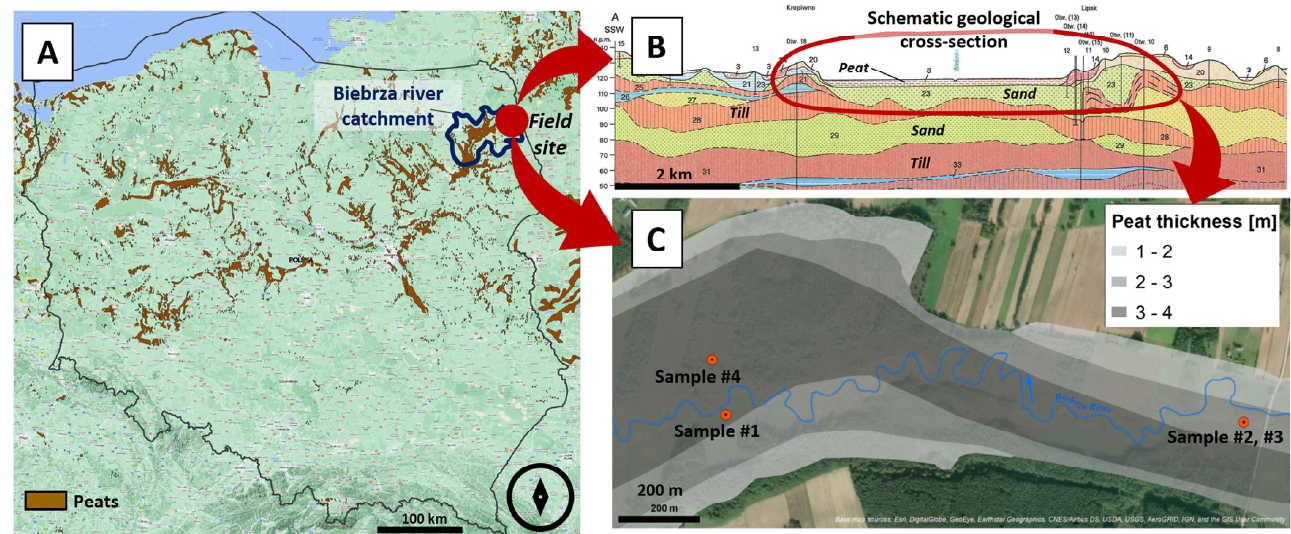
Figure 2. ( A ) Localization map, ( B ) a cross-section of the peat-forming region modified from [32] where the analysed samples were collected, and ( C ) the sampling site.